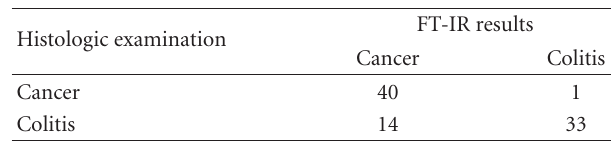
Table 1: Comparison of FT-IR results with histological examina- tion.